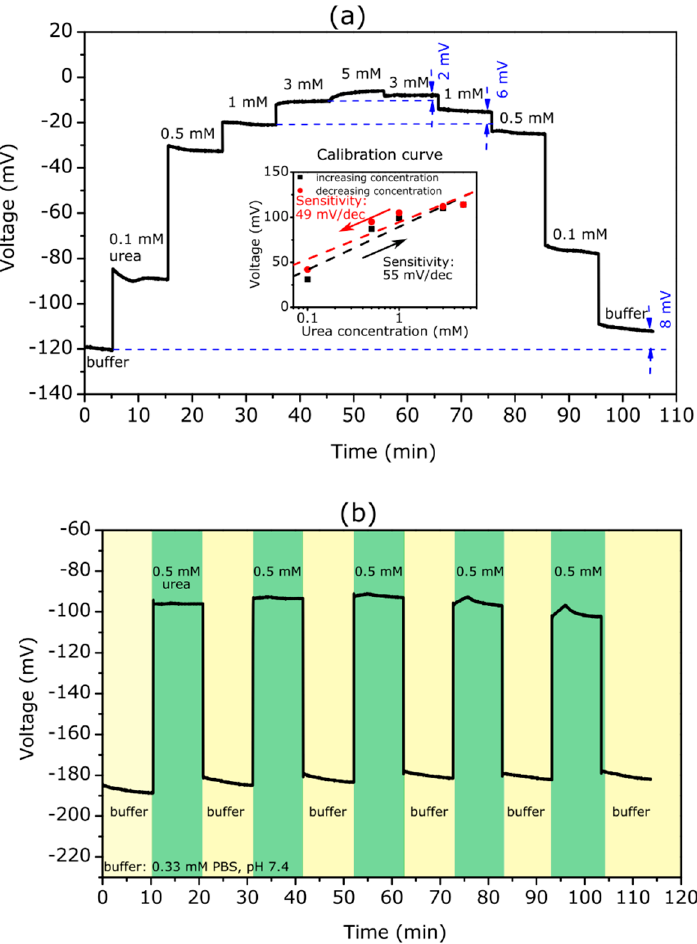
Figure 3. ( a ) ConCap curve of a TMV/SA-urease-modified EISCAP recorded in 0.33 mM PBS buffer (pH 7.4) with different urea concentrations between 0.1 and 5 mM. The inset figure presents the resulting calibration curves with a urea sensitivity of about 55 and 49 mV/dec for increasing (black) and decreasing (red) concentration series of measurements, respectively. ( b ) Reproducibility of the TMV-assisted EISCAP urea biosensor: the ConCap signal was repeatedly measured in buffer solu- tion and in 0.5 mM urea solution in alternating